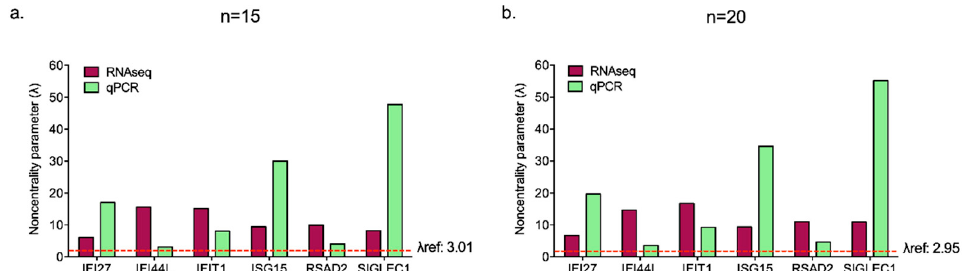
Figure 6. Graphical representation of λ calculated for each ISG by in silico RNAseq analysis and hypothesized qPCR assessment considering fifteen ( a ) and twenty ( b ) subjects. The λ refs values are displayed by the red dashed line and reported in the figure. Sample size is considered appropriate when λ computed on each gene is higher than λ ref.